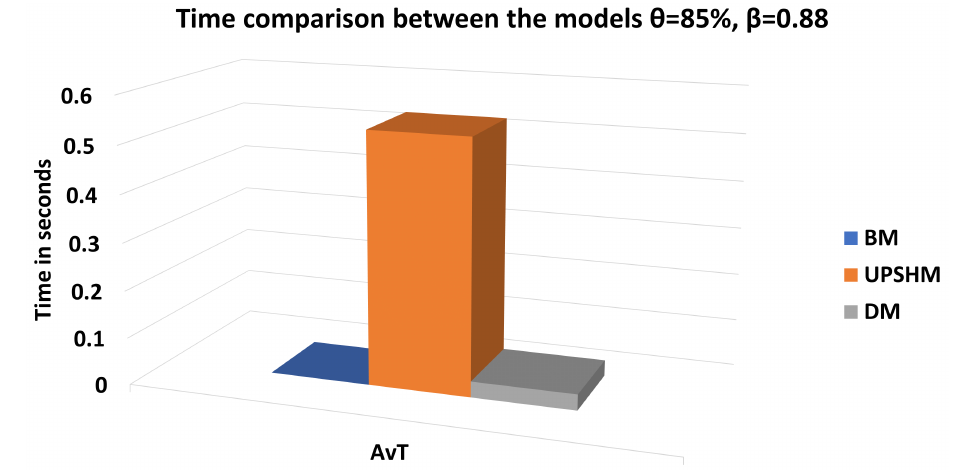
Figure 6. Time comparison of results for BM, UPSHM, DM.